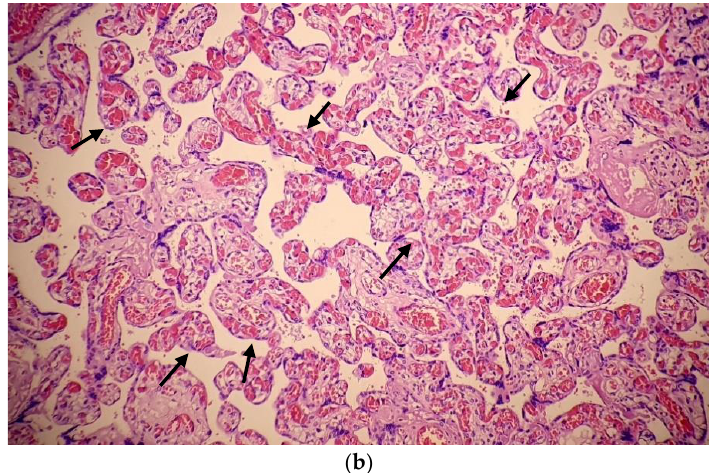
Figure 1. ( a ): Placenta with diffuse chorioangiosis (×4); ( b ): Important vascular changes of the terminal chorionic villi consistent with chorioangiosis (black arrows) (×10).